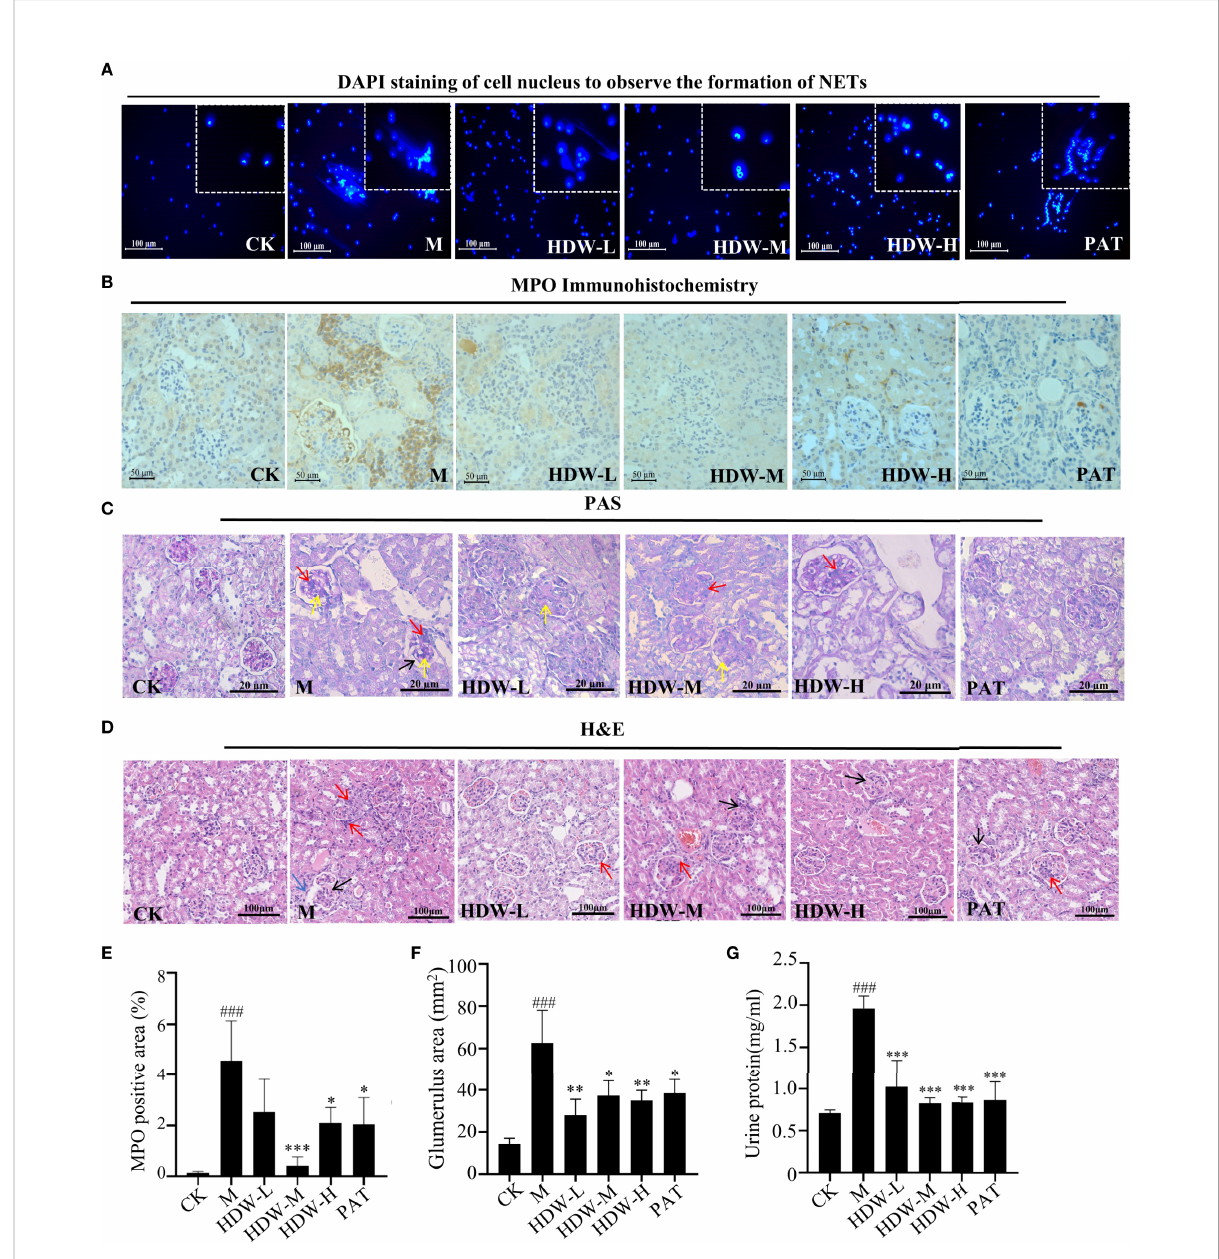
FIGURE 5 The effect of HDW on NETosis formation and histopathological changes in MRL/lpr mouse kidneys. (A) The Effect of HDW on NETosis formation of bone marrow neutrophils. DAPI staining is shown in blue. (B) MPO immunohistochemistry staining. Brown deposits are protein- positive deposits. (C) Representative periodic acid-Schiff (PAS)-stained sections: red arrows mark increased in fl ammatory cells; yellow arrows mark thylakoid hyperplasia; black arrows mark basement membrane thickening. (D) Representative hematoxylin and eosin (H&E) sections: red arrows mark increased in fl ammatory cells; black arrows mark thylakoid hyperplasia; blue arrows mark glomerular crescent. (E) The MPO staining was quanti fi ed by pixel counting of sections using ImageJ. (F) Areas of glomerular volume. (G) Urinary protein levels in MRL/lpr mice. #Indicates the difference between the model group and the control group, ### P < 0.001; * Indicates the difference between the treatment group and the model group * P < 0.05, ** P < 0.01, *** P <